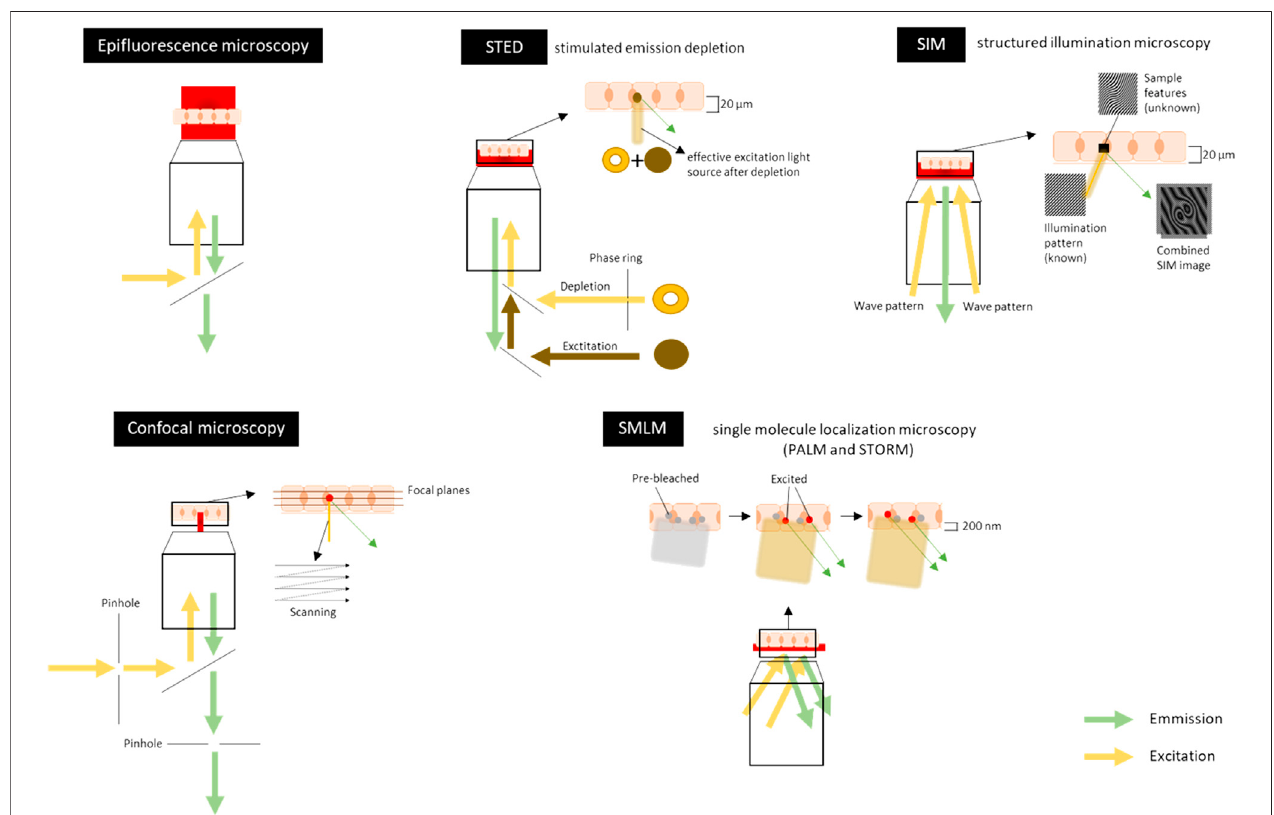
FIGURE5| Schematicoverviewofvisiblelight-basedtechniquesforimagingthetightjunctions,adherensjunctionsanddesmosomes.Sampleisrepresentedhere as a layer of cells, which can either be fi xed (chemically or by cryo-freezing) or non- fi xed (live-cell imaging). The sample can also be a tissue section. In Epi fl uorescence microscopytheilluminationlightistransmittedthroughthesamplewhichexcites fl uorescentmoleculesinthestainedsample.Itvisualizesthe(sub)-cellularstructuresina large fi eldofviewinthesampletoget ageneraloverview oftheintercellularjunctions.Confocalmicroscopy useslasers toilluminate andscanthetissue atacertain depth (focal plane). Pinholes are present to physically block out-of-focus light and to eliminate or reduce background information away from the focal plane. Emitted fl uorescence is recorded. Scanning can be done at each focal plane to make optical sections throughout the tissue (5 – 30 µm). The lateral (xy) resolution is 500 – 100